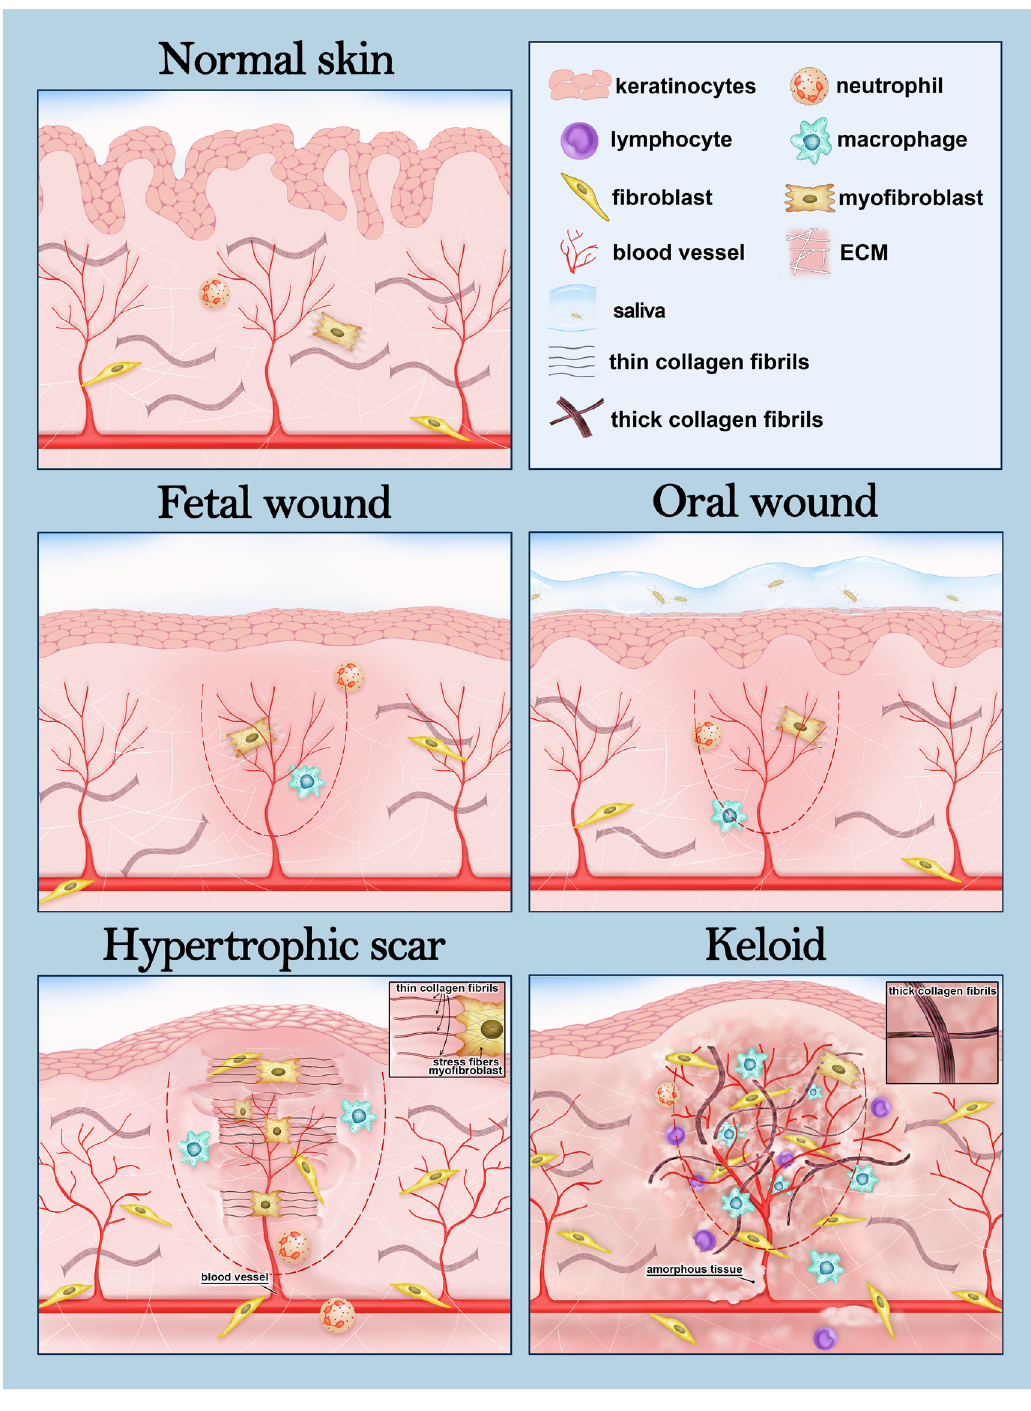
Figure 1. Foetal and oral wound healing and different types of fibrotic skin scars. A schematic drawing showing the structures of normal skin, scarless foetal and oral wounds, and the two main types of fibrotic cutaneous scars. The wound area is depicted with a dashed line. Foetal and oral wound healing share many characteristics. For example, these wounds contain a low number of myofibroblasts and extracellular matrix (ECM) does not accumulate in the wound bed. In addition, the inflammatory reaction is weak, which is manifested here by the low number of inflammatory cells in the wound. In oral wounds, saliva offers a humid environment with microbes, which is suggested to promote oral wound healing. The hypertrophic scar is limited to the area of the original wound and contains plenty of contracting myofibroblasts, which adhere to ECM via focal adhesion-like structures. Thin collagen fibres in the ECM are orientated in parallel to the cutaneous epithelia (insert). The keloid scar transcends the edges of the wound and extends into the surrounding skin. The inflammatory reaction is strong, dermal fibroblasts proliferate actively and thick hyalinised collagen bundles are orientated randomly (insert). Chronic inflammation persists, and angiogenesis is active in the keloids.